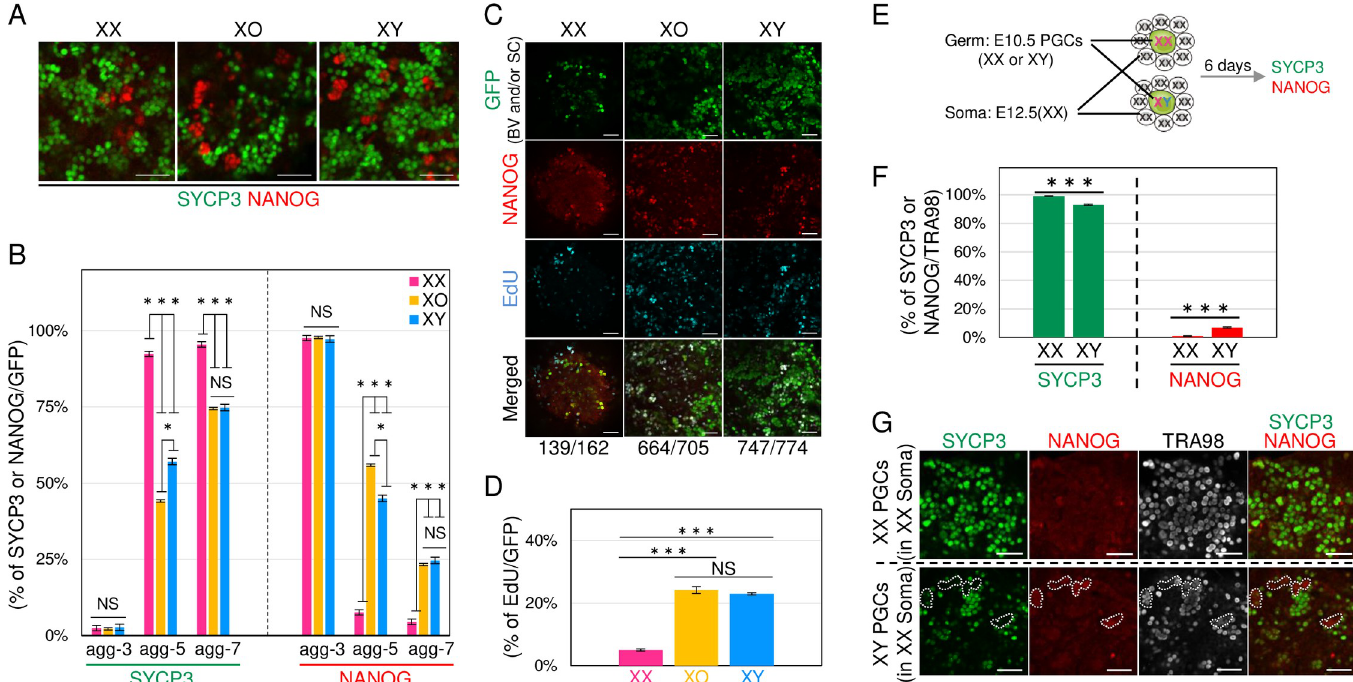
Fig 3. Meiotic initiation and progression in XX, XO and XY PGCLC/oocytes. ( A ) Meiotic initiation in XX, XO and XY PGCLC/oocytes. Images show the immunofluorescence analysis of SYCP3 (green) and NANOG (red) in PGCLCs/oocytes at agg-7. Scale bars, 50 μ m. ( B ) Time-course of meiotic entry. The graph shows the average percentage and SD of SYCP3- or NANOG-positive cells at the days indicated. The data were compiled from two independent experiments. ( C ) EdU incorporation into NANOG-positive cells. Images show the immunofluorescence analysis of BV/SC (green), NANOG (red), EdU (Blue) and their merged images in rOvaries. The number below the images indicates NANOG-positive cells per EdU-positive cells. Scale bars, 50 μ m. ( D ) The percentage of EdU-positive cells per BV- and/or SC-positive cells. The graph indicates the average percentage and SD of EdU-positive cells per BV- and/or SC-positive cells. The data were compiled from two independent experiments. ( E ) Schematic diagram of the reconstitution experiment using PGCs derived in vivo. XX or XY PGCs of E10.5 embryos were reaggregated with gonadal somatic cells of E12.5 female embryos. ( F ) The percentage of cells entering meiosis. The graph shows the average percentage and SD of SYCP3- or NANOG-positive cells at the days indicated. The data was compiled from four independent experiments. P values were calculated by t -test. ��� P < 0.001. ( G ) NANOG-positive XY germ cells in the rOvary. Images show the immunofluorescence analysis of SYCP3 (green), NANOG (red), TRA98 (a marker of germ cells: white) and their merged images. The dashed lines indicate representative NANOG-positive germ cells. Scale bars, 50 μ